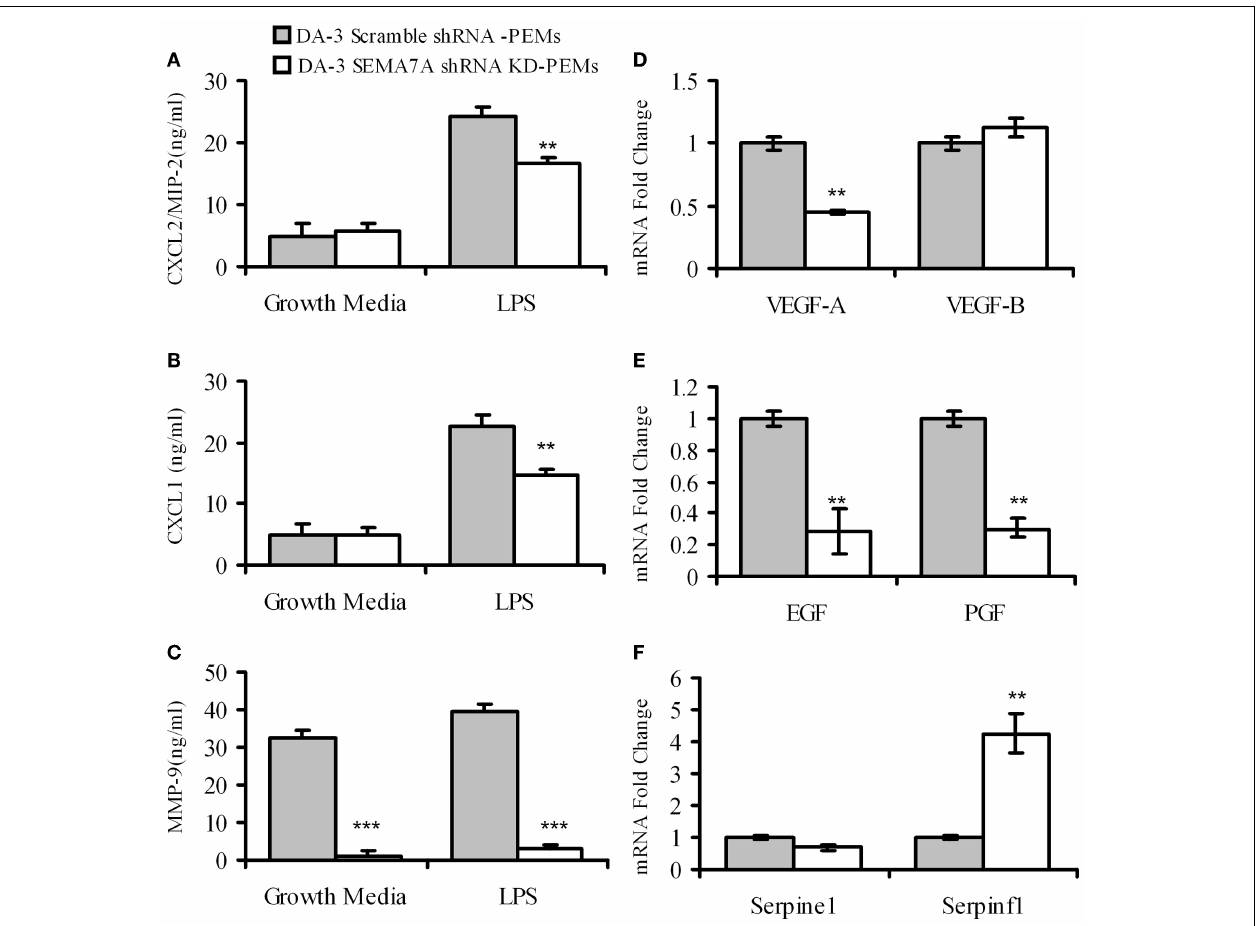
FIGURE 6 | Macrophages from mice bearing SEMA7A shRNA knockdown tumors produce decreased levels of angiogenic molecules. ELISA of peritoneal macrophages from scramble shRNA DA-3 and SEMA7A shRNA knockdown DA-3 tumor bearers cultured with and without LPS for protein levels of: (A) CXCL2/MIP-2; (B)